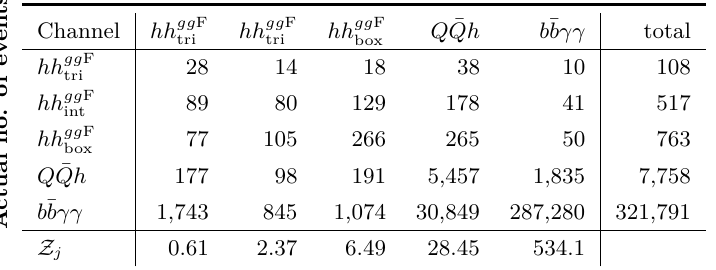
Table 3 . Trained BDT classification (confusion matrix) of the five channels used to extract constraints on C (or κ ) at HL-LHC with 6 ab − 1 luminosity (ATLAS+CMS), assuming SM signal φ λ injection. The right-most column gives the total number of events expected in each channel in the SM and the bottom-most row gives the signal significance.